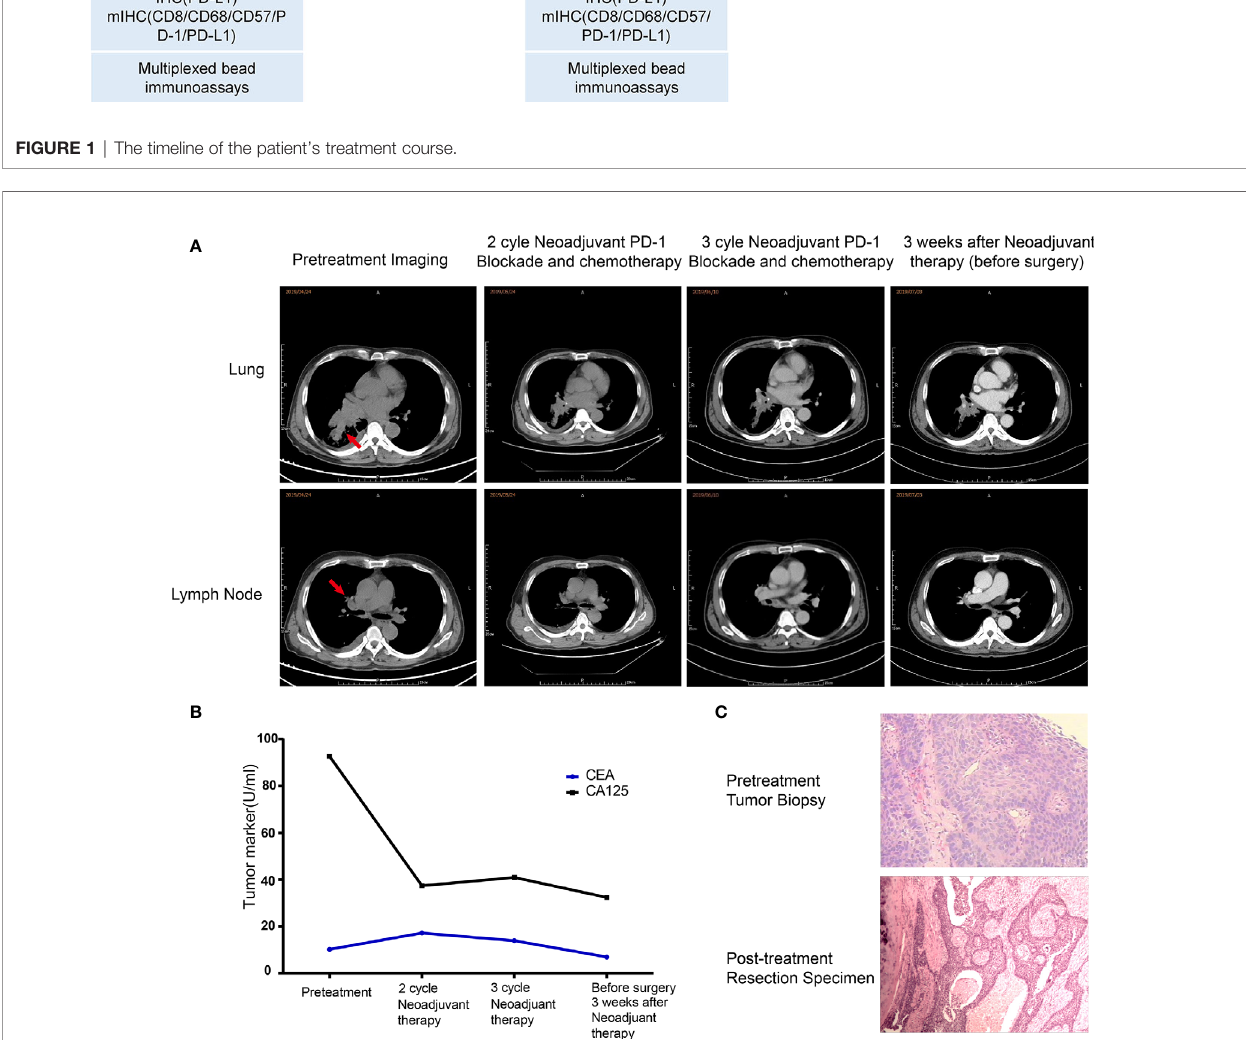
FIGURE 2 | Changes in clinical indexes before and after neoadjuvant immunochemotherapy. (A) Representative CT images during neoadjuvant immunochemotherapy. (B) Carcinoembryonic antigen test results during neoadjuvant immunochemotherapy. (C) Histological results of the pretreatment tumor biopsy (hematoxylin and eosin (HE) staining, magni fi cation ×200) and surgically resected tissue (HE, magni fi cation